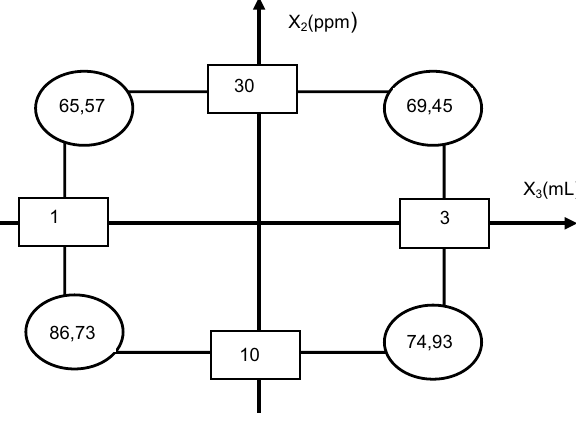
Fig. 5 Interaction between initial concentration of RhB ( X hydrogen peroxide volume ( X 3